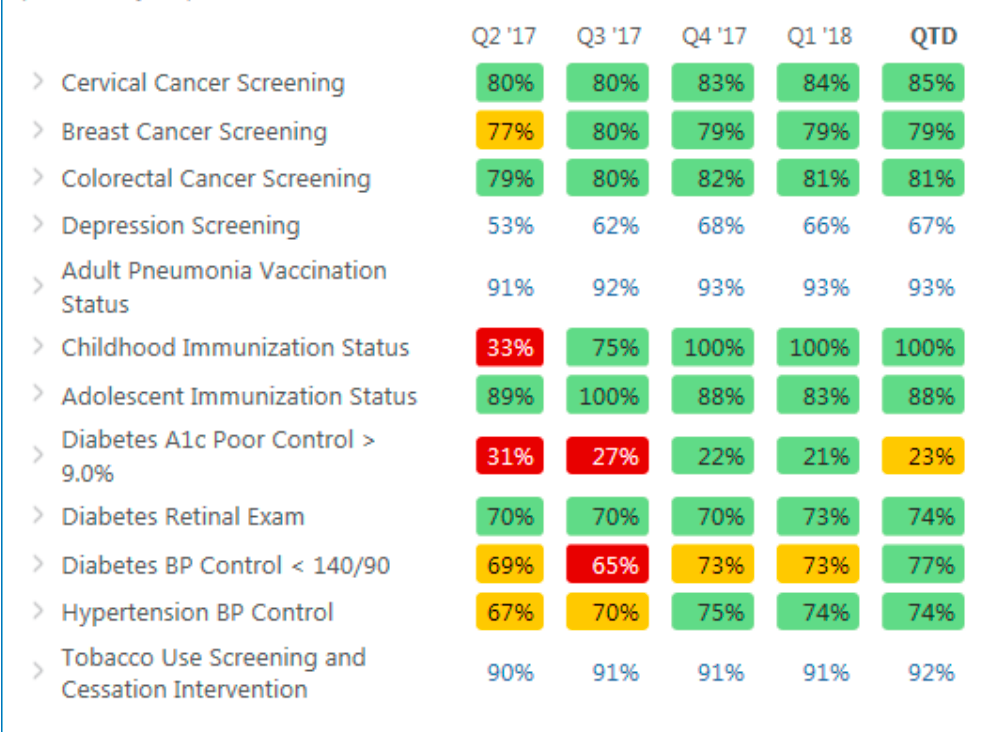
Figure 2. Population health metrics. BP is blood pressure.